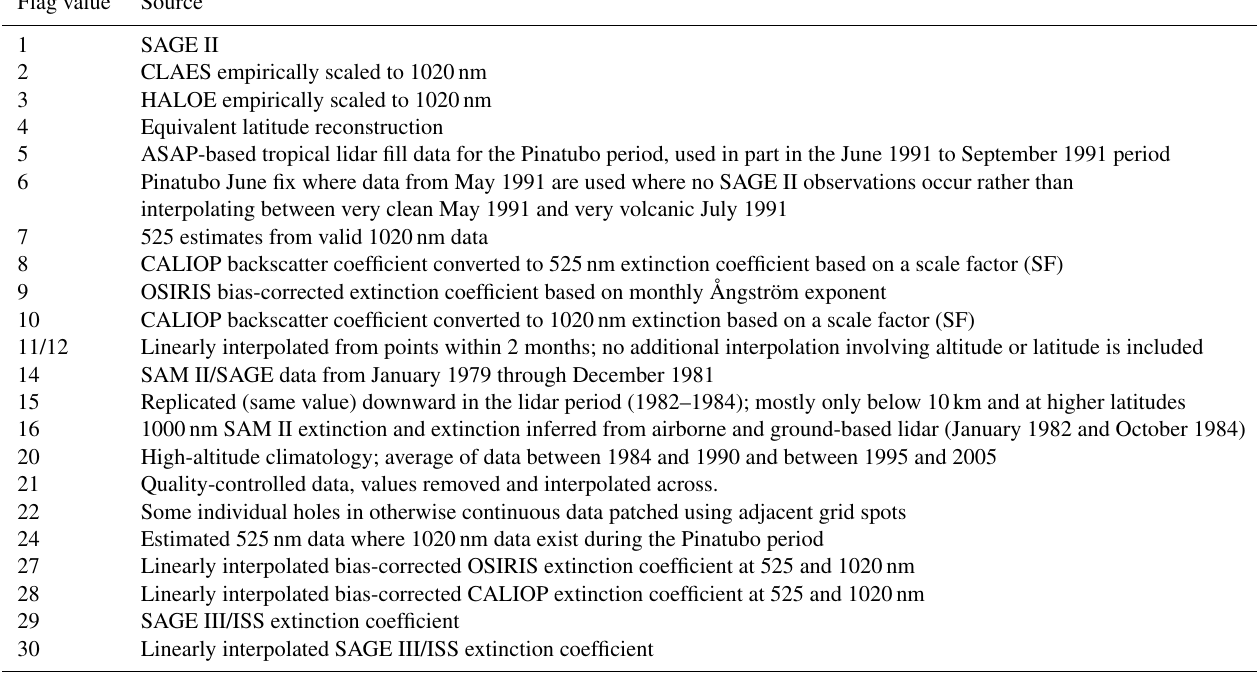
Table B2. GloSSAC data flag values and